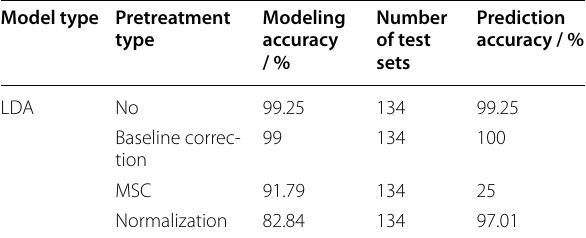
Table 3 The LDA model of results after band selection of absorption coefficient spectrum Model type Pretreatment type